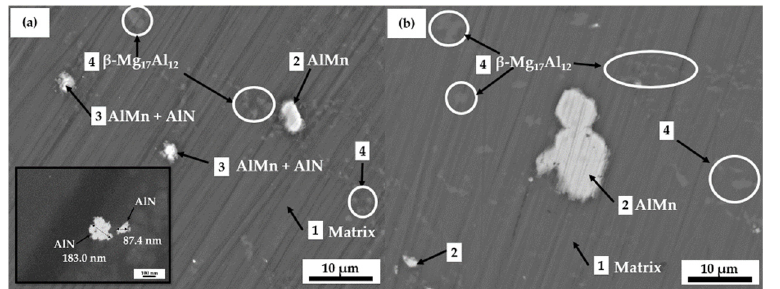
Figure 1. SEM images (×2000) of ( a ) AM60-AlN nanocomposite and ( b ) AM60 alloy reference samples [44].